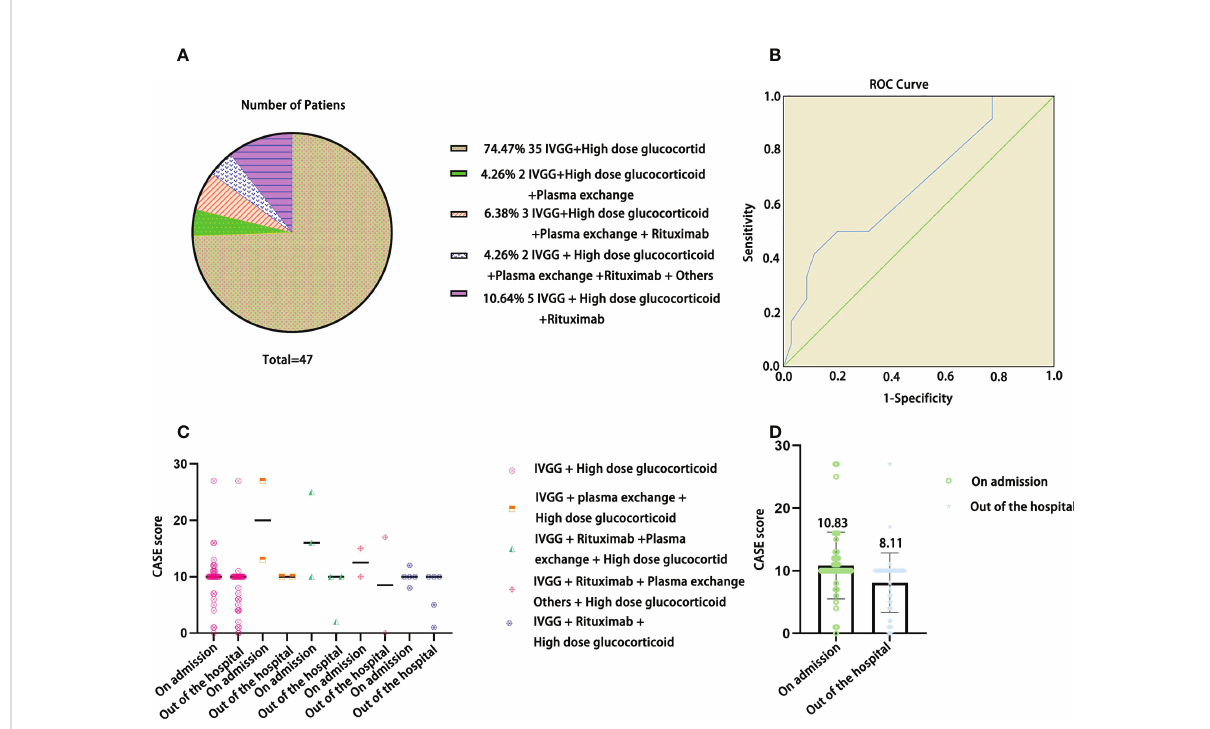
FIGURE 5 The distribution of treatment plans in the current pediatric AE cohort (A) , ROC curve of the CASE total score as a predictor of the patients who needed second-line treatment (B) , CASE scores at admission and discharge among different treatment plans (C) , and CASE total scores of the current pediatric AE cohort at admission and discharge (D)